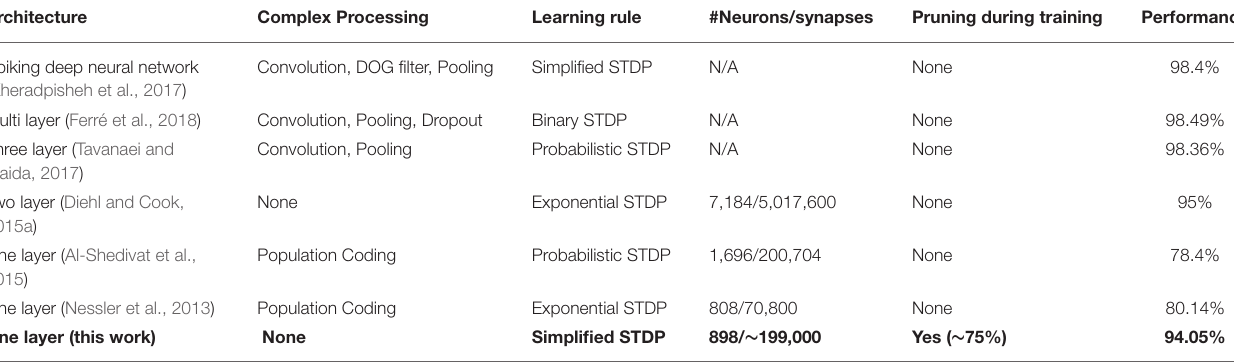
TABLE 3 | Classification accuracy comparison between this work and the state-of-the-art software demonstrations of unsupervised learning of SNNs on the MNIST dataset. Architecture Complex Processing Learning rule #Neurons/synapses Pruning during training